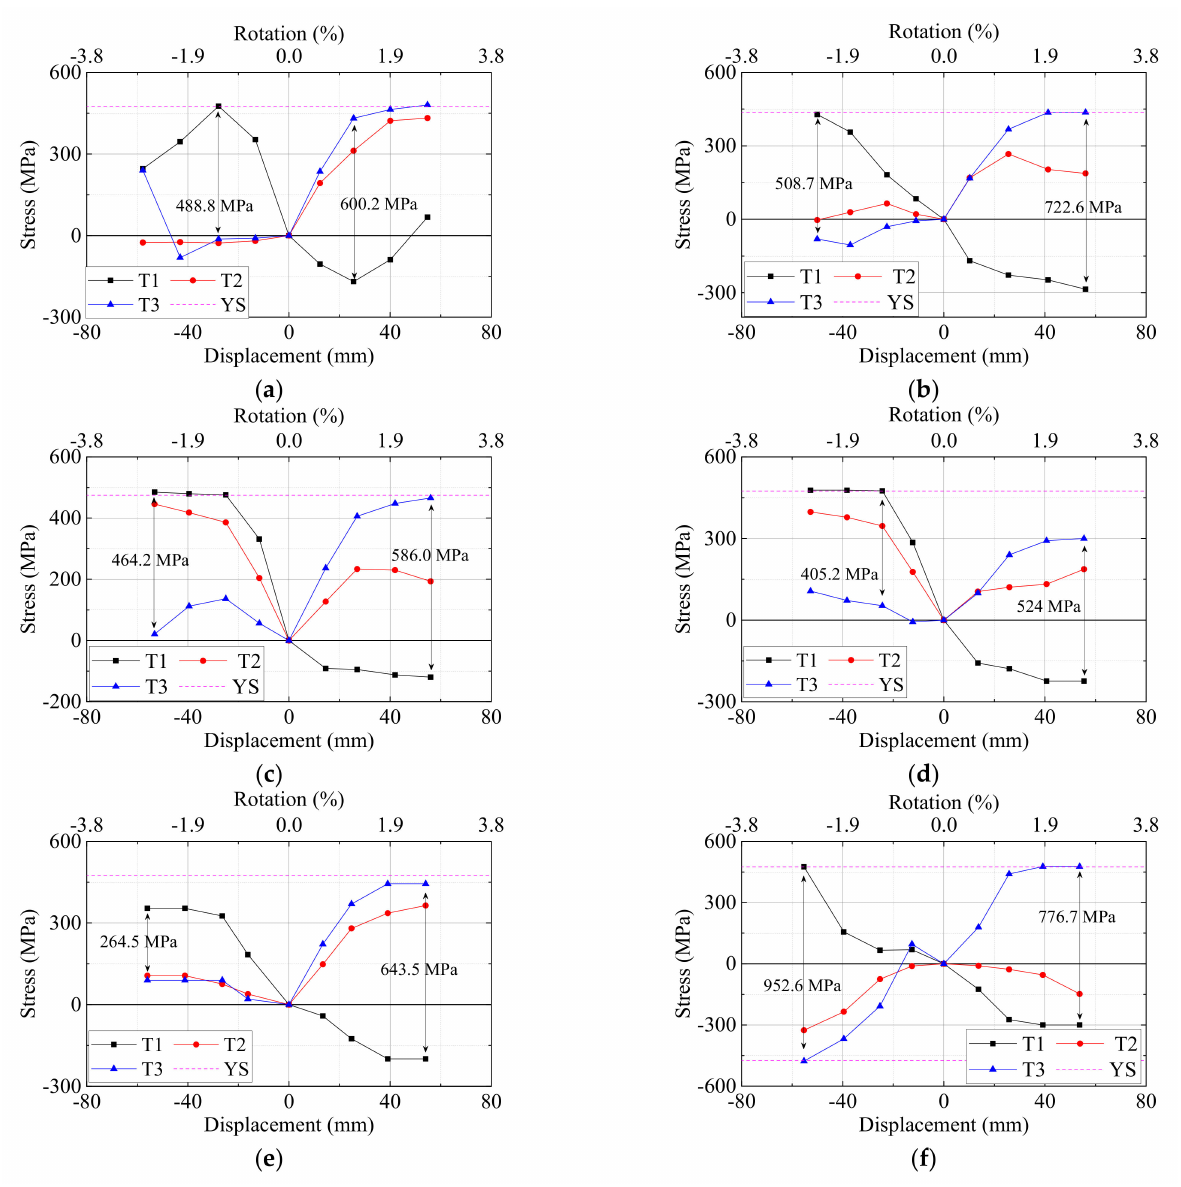
Figure 17. Stress versus displacement envelope curves. ( a ) Specimen PI1, ( b ) Specimen PI2, ( c ) Speci- men PI3, ( d ) Specimen PI4, ( e ) Specimen PI5, ( f ) Specimen